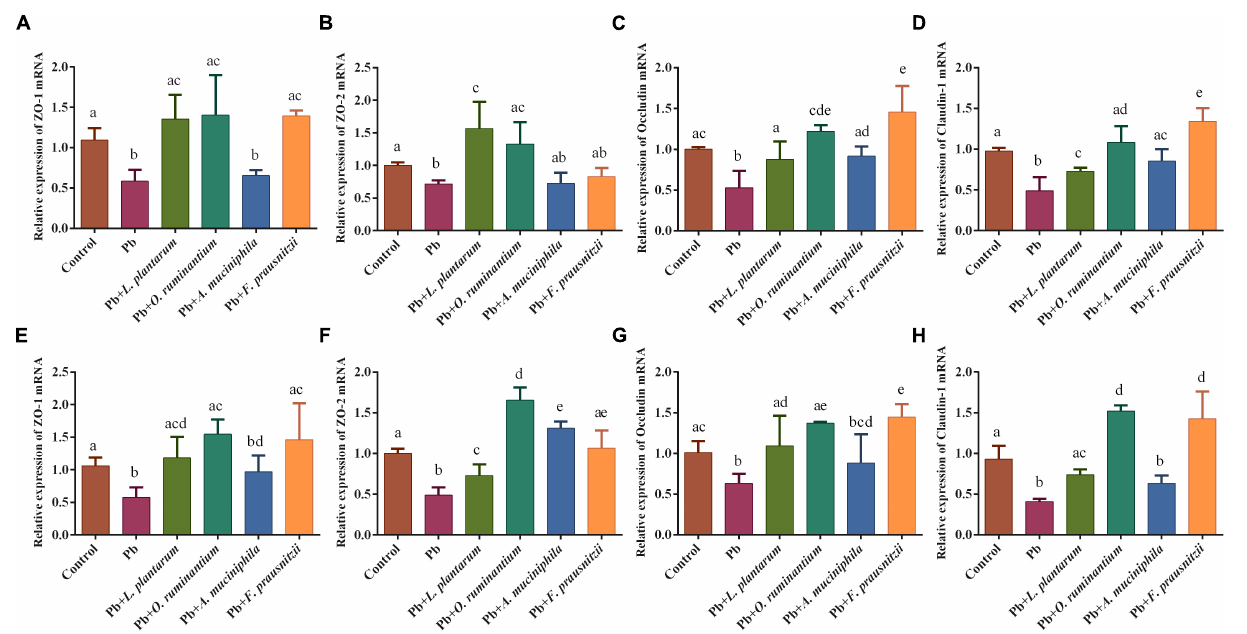
FIGURE 5 | The effects of Pb-intolerant gut microbes on mRNA expression of TJ genes in representative sections of colon (A–D) and small intestine (E–H) of chronic Pb-exposed mice ( n = 6). Letters a–e denote statistically significant differences between each group ( p <